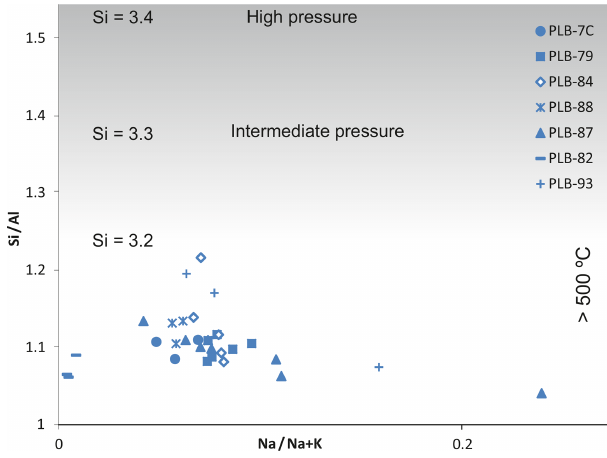
Figure 6. Compositional diagram of white micas showing Na / Na + K vs. Si / Al (atomic ratios) for 31 EPMA point analyses from seven samples of the lower formations of the Pulo do Lobo domain (differ- ent symbology for each sample). Point analyses were conducted on the microprobe at the University of Huelva (Spain). Qualitative in- formation about temperature and pressure conditions is respectively according to Guidotti et al. (1994), Coggon and Holland (2002), Parra et al. (2002), Massonne and Schereyer (1987), and Massonne and Szpurka